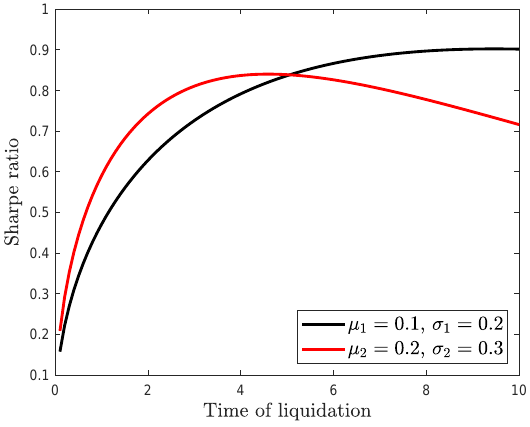
Figure 1: Sharpe ratios as a function of time. Figure 1. Sharpe ratios as a function of